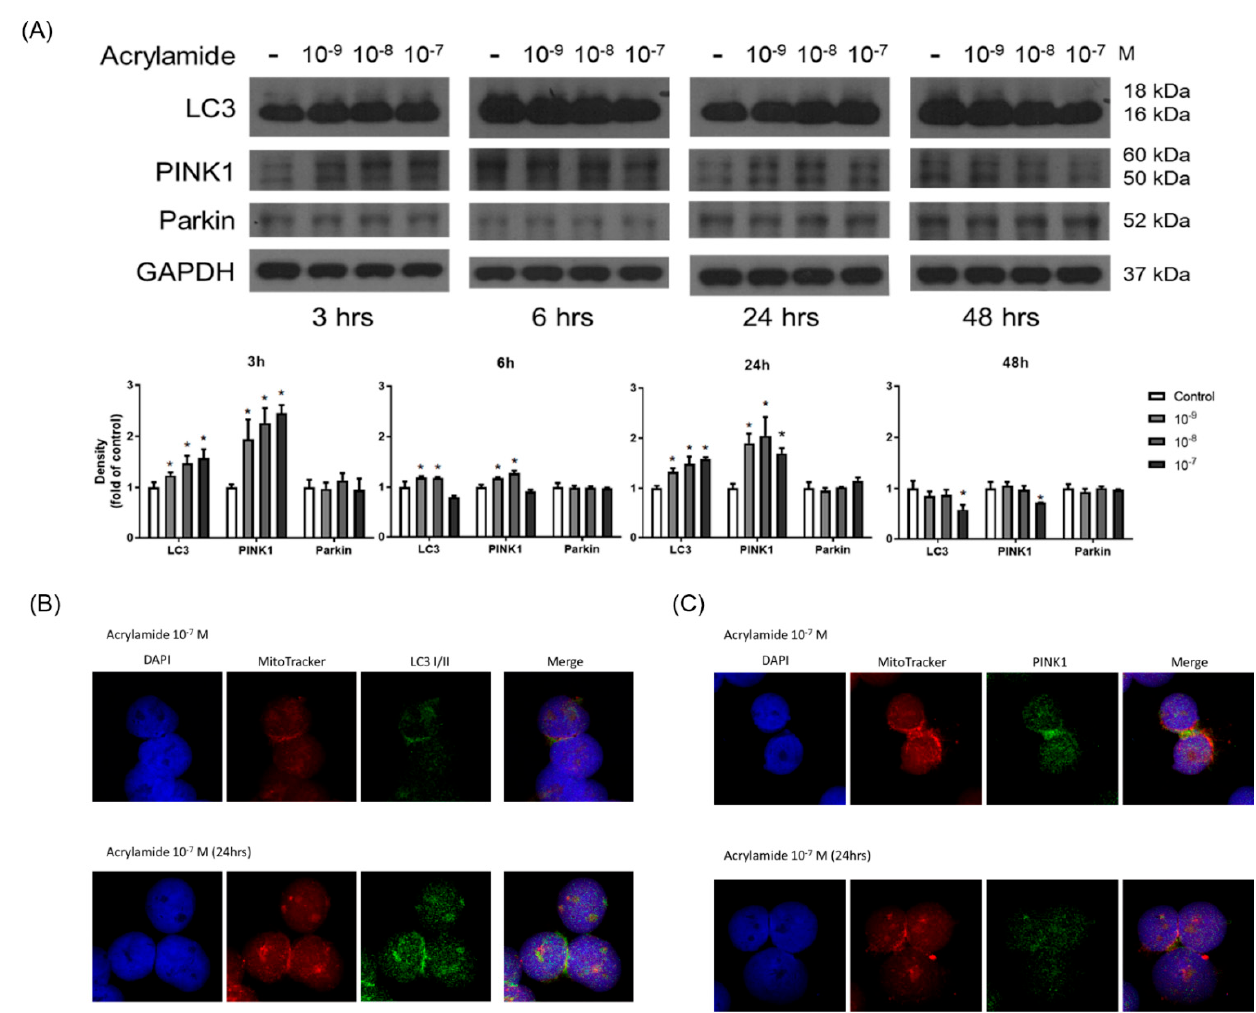
Figure 4. Acrylamide induced mitophagy in THP-1 cells. ( A ) Western blotting of LC3, PINK1, and Parkin in acrylamide- treated THP-1 cells ( n = 4). ( B , C ) By immunofluorescence staining, the co-localization mitochondria (by mito-tracker; red) and LC3 or Parkin (green) were tested ( n = 3). * p < 0.05, by the Kruskal-Wallis test.